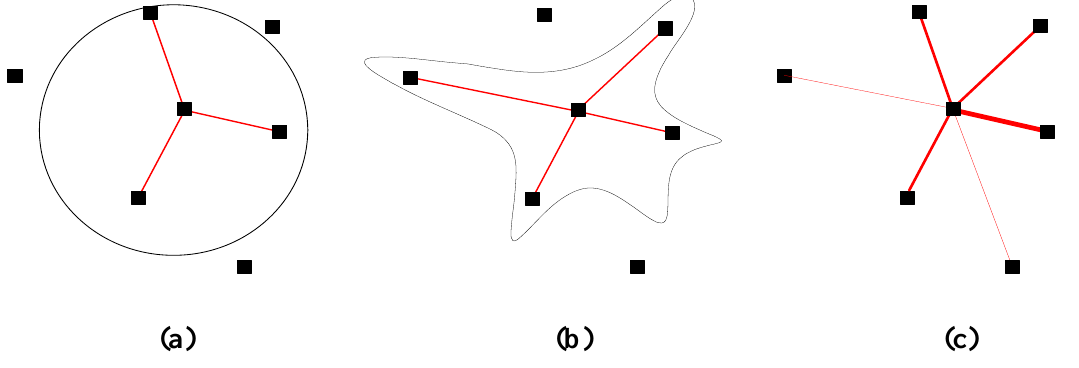
Figure 1. Different kinds link models. (a) Boolean disk model. (b) Shadowing model. (c) Probabilistic